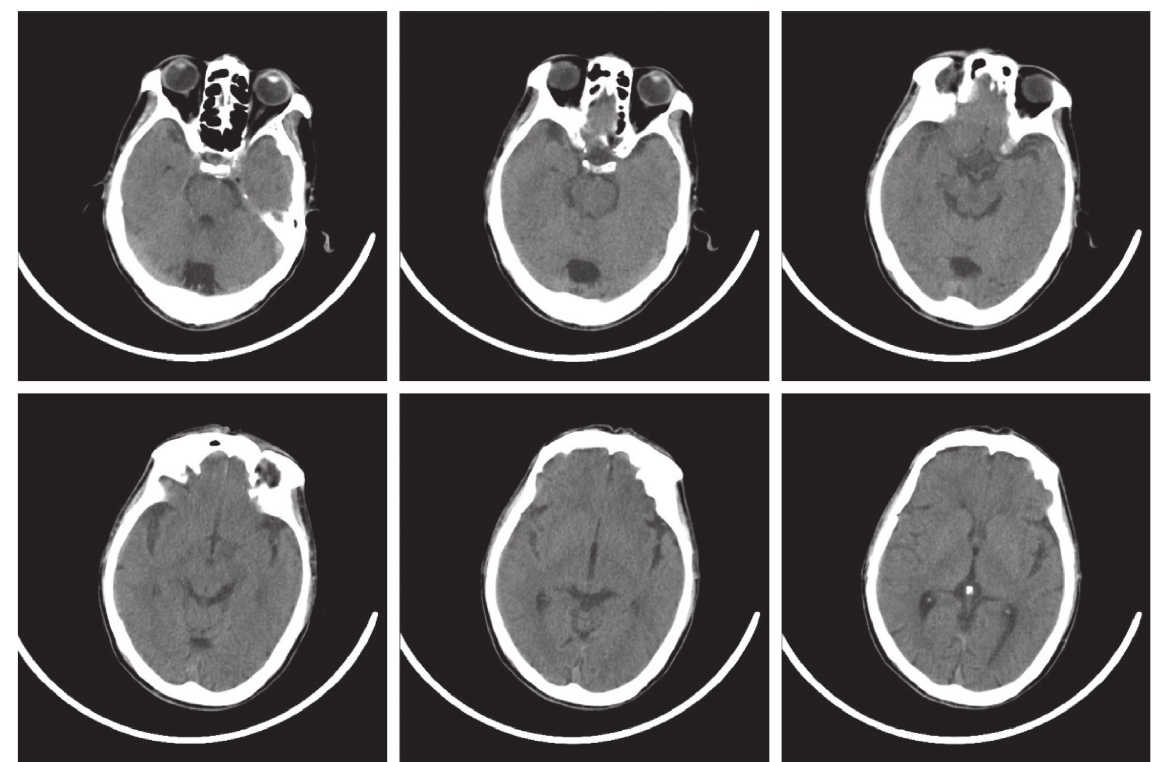
Figure 1: The CT image in July 28th. No blood could be seen.